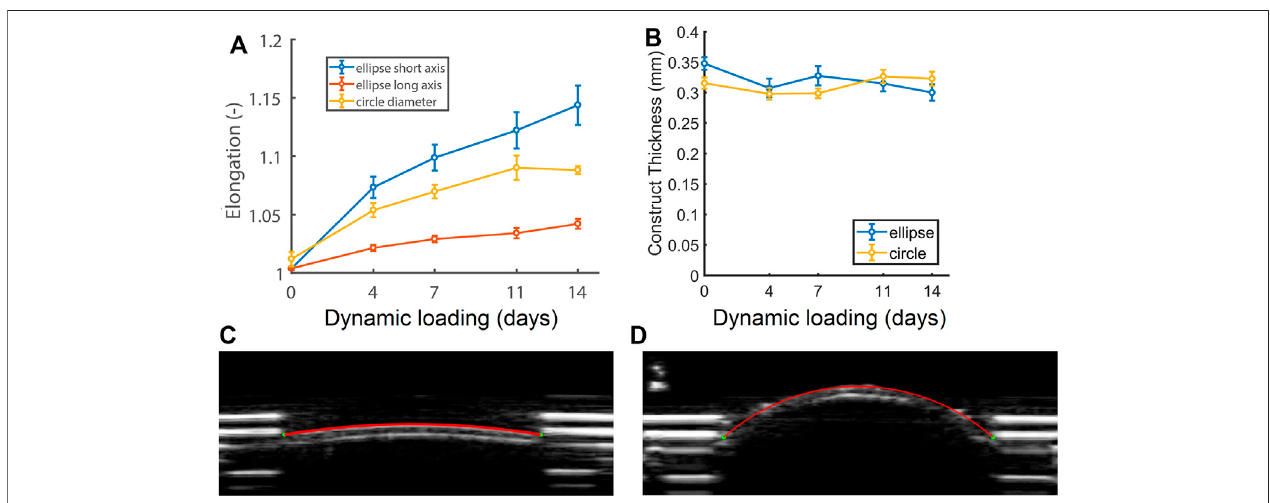
FIGURE3|(A) Relativechangesincross-sectionallengthatzeropressurewithrespecttotheinitiallengthatthestartoftheexperiment( L / L 0 )oftheshort(blue)and long (red) axis of the elliptical constructs and the diameter of the circular constructs (yellow), as well as (B) construct thickness during 14 days of dynamic loading. See supplemental materialfor p -values. (C) Ultrasoundimage ofacircularconstructatthestartofdynamicloading,and (D) adilatedcircularconstructattheendofdynamic loading at zero pressure ( p =